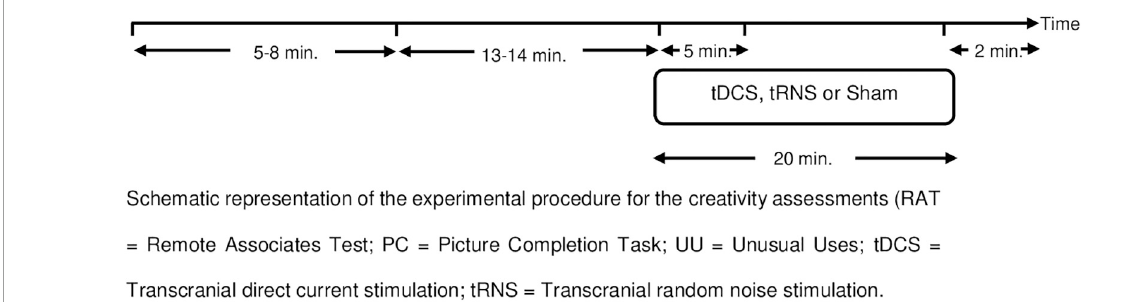
FIGURE1 Study design. Schematic representation of the experimental procedure for the creativity assessments. RAT, remote associates test; PC, picture completion task; UU, unusual uses; tDCS, transcranial direct current stimulation; tRNS, transcranial random noise